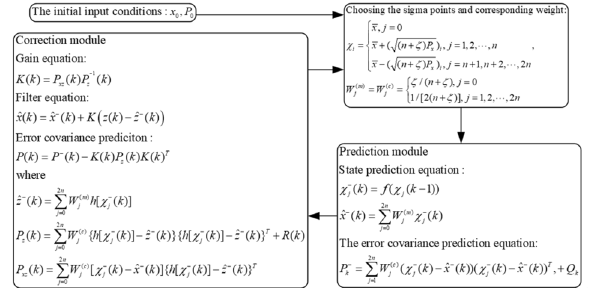
Figure 4 Procedure of UKF